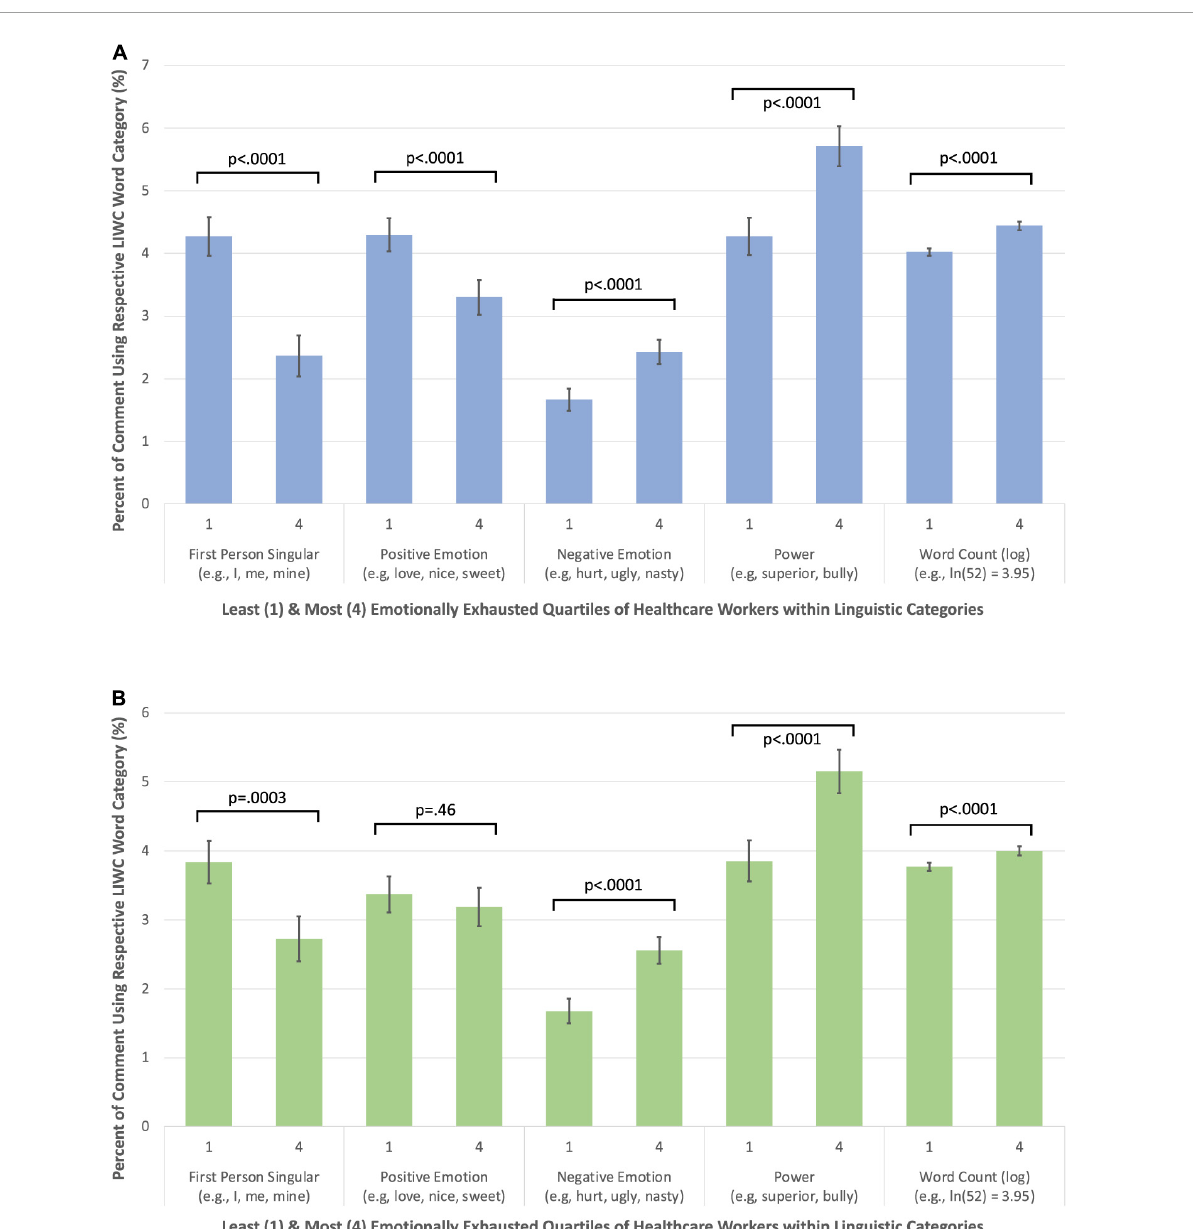
FIGURE1 (A) The linguistic profiles of the least and most emotionally exhausted healthcare workers (HCWs) [2019 emotional exhaustion (EE) and 2019 comments]. (B) The linguistic profiles of the least and most emotionally exhausted HCWs (2020 EE and 2020